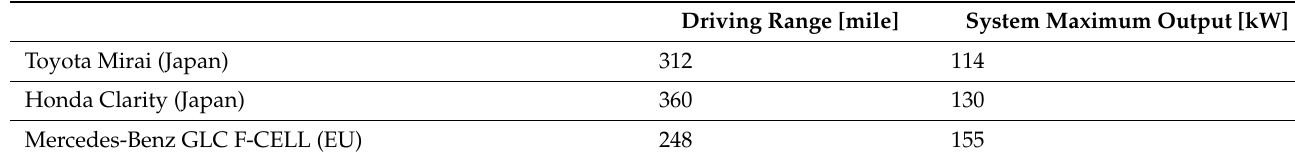
Table 6. The main characteristics of various FCEVs.